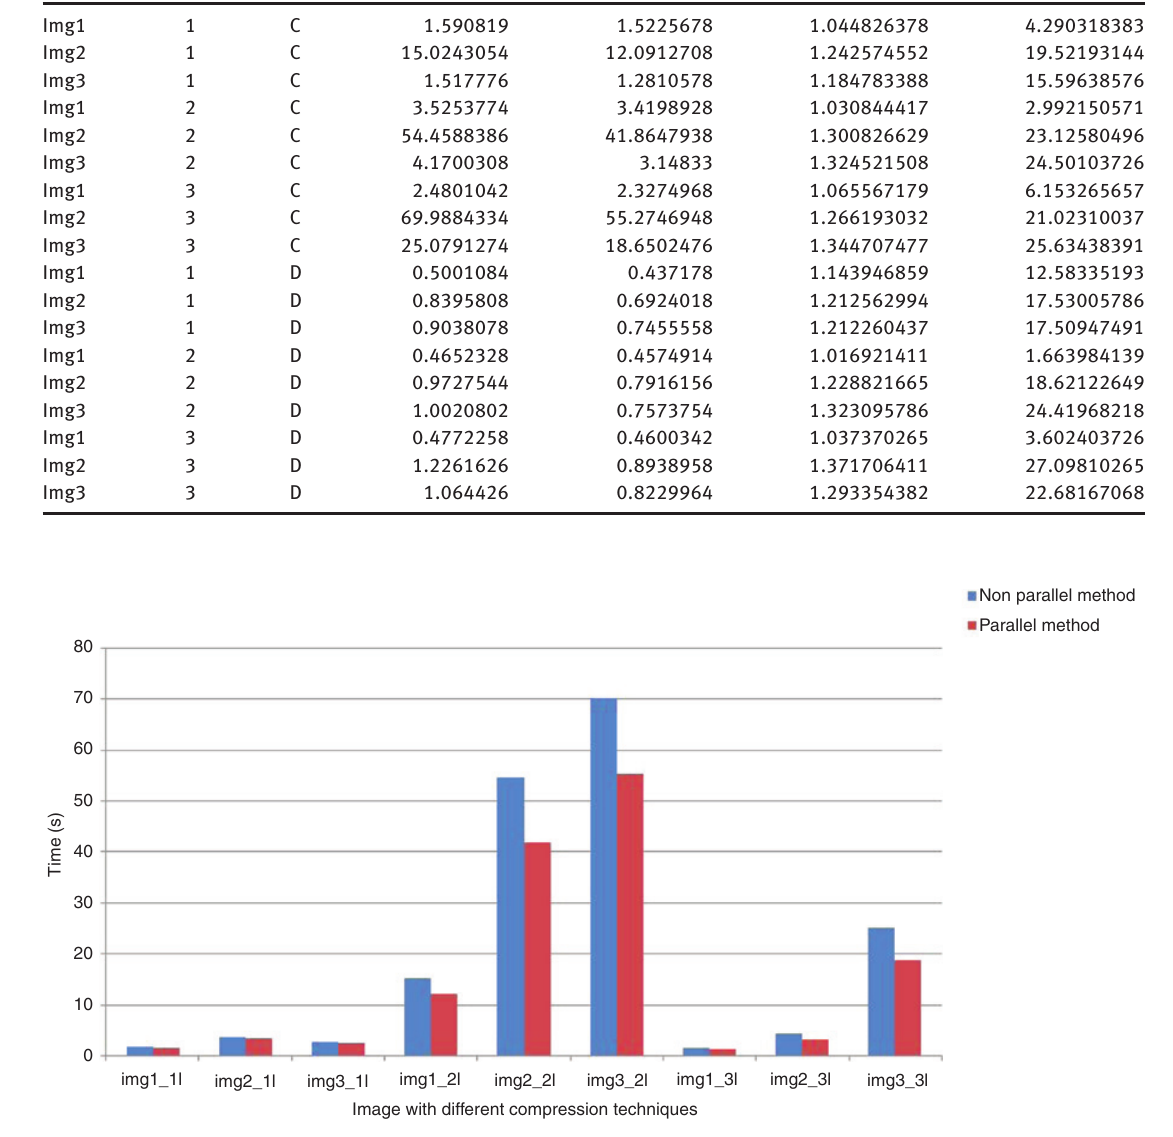
Figure 3: Comparative Study of Compression